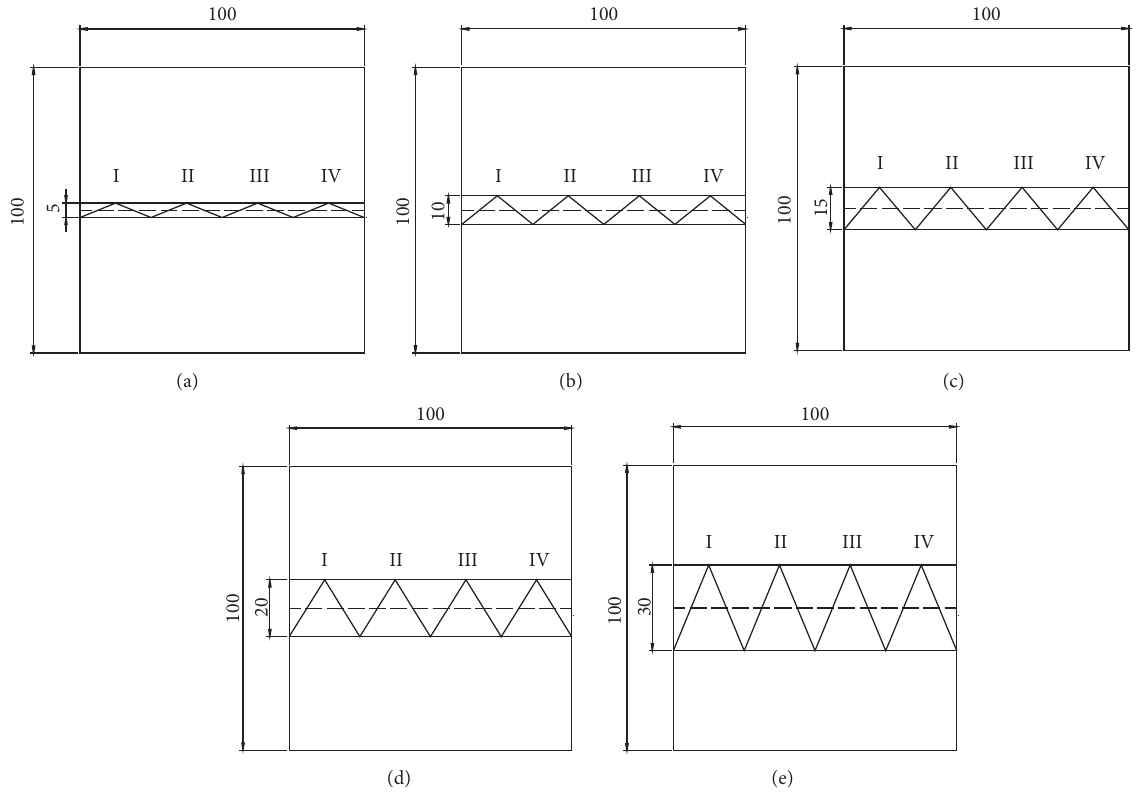
Figure 1: Schematic diagram of rock specimens with different undulating heights. (a) B-5. (b) B-10. (c) B-15. (d) B-20. (e) B-30.